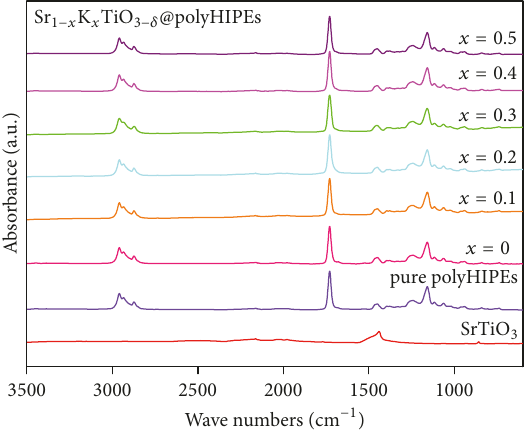
Figure 3: Ftir spectra of Sr 1−𝑥 K 𝑥 TiO 3−𝛿 @PC-polyHIPEs and PC- polyHIPEs.